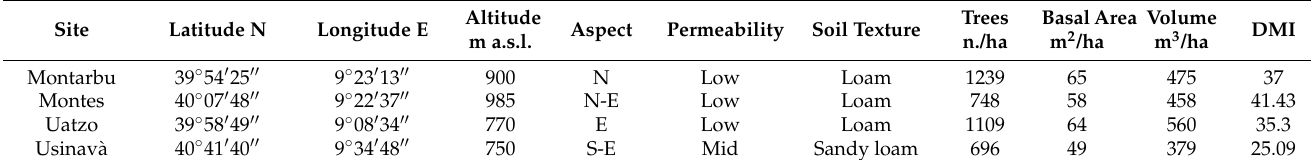
Table 1. Stand attributes of the four common gardens (experimental sites). Number of trees per ha, basal area, and tree volume (calculated according to the national forest inventory equations [34]) are referred to the year of last field sampling (2018), and De Martonne Index (DMI) for each site for the period of study